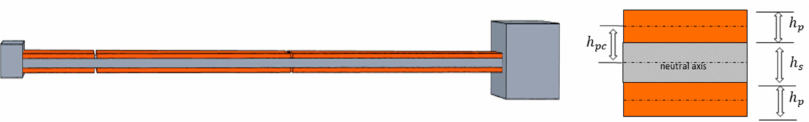
Figure 2. Side view of the segmented PEH.